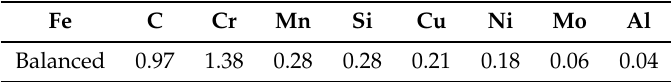
Table 1. Composition of 100Cr6 in this research (all values in wt%).